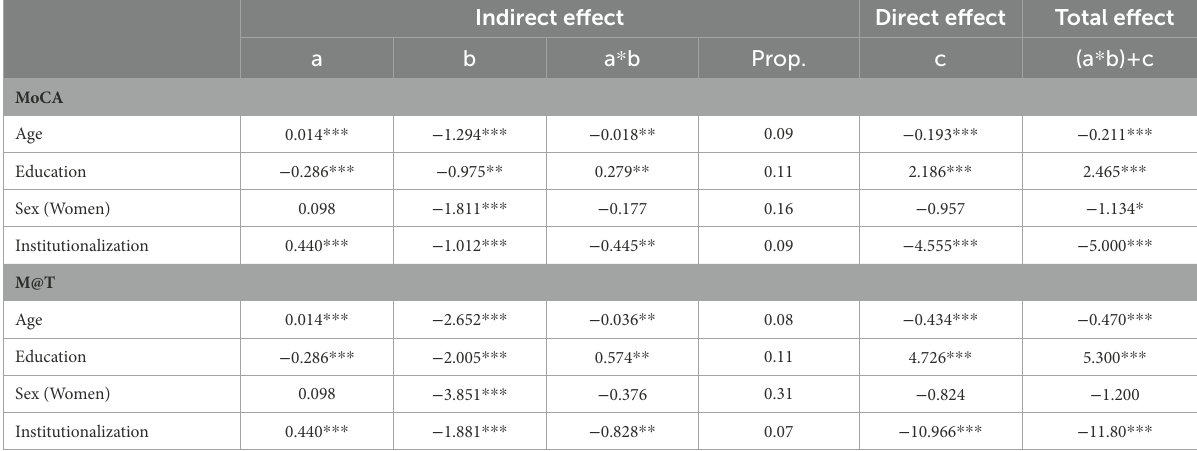
TABLE 2 Mediation analysis of the four sociodemographic predictors of cognitive performance (assessed with the MoCA and M@T) contrasted with physical reserve as a mediating variable (assessed with the IPAQ).